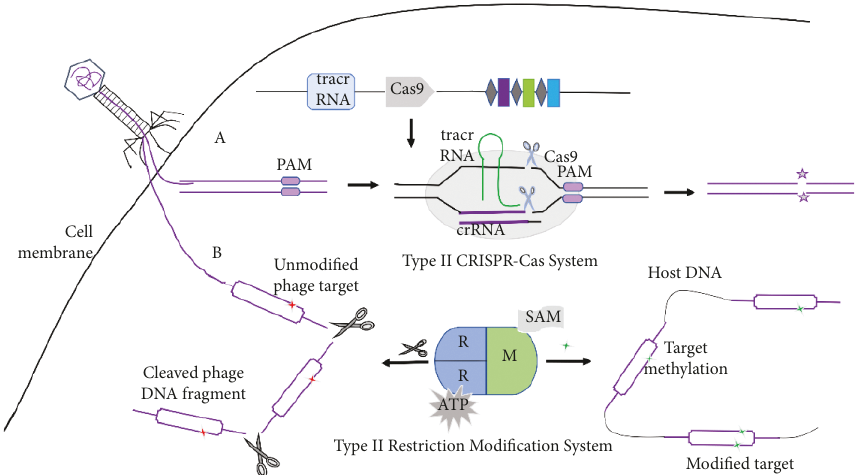
Figure 2: The mechanism of type II CRISPR-Cas system (a) and type II restriction-modification system